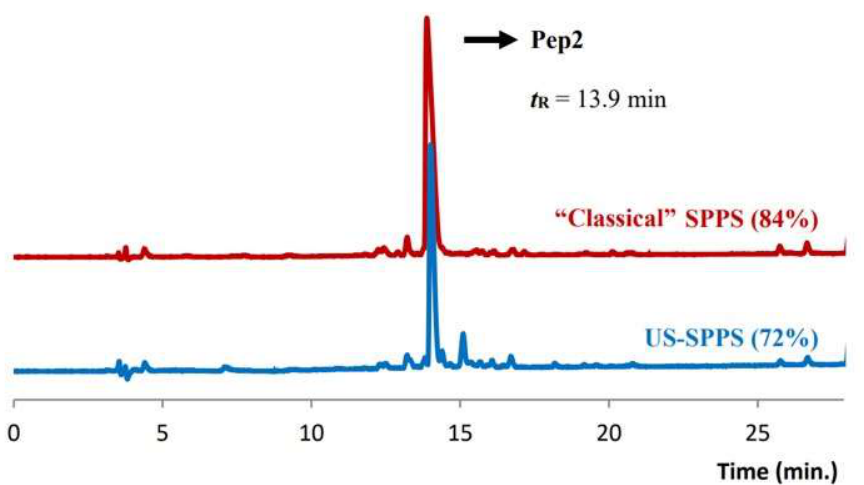
Figure 4. Analytical RP-HPLC chromatograms obtained for crude Pep2 ( t R = 13.9 min); comparison between the products obtained by US-SPPS (blue) and “classical” SPPS (red). Gradient B (see experimental section).